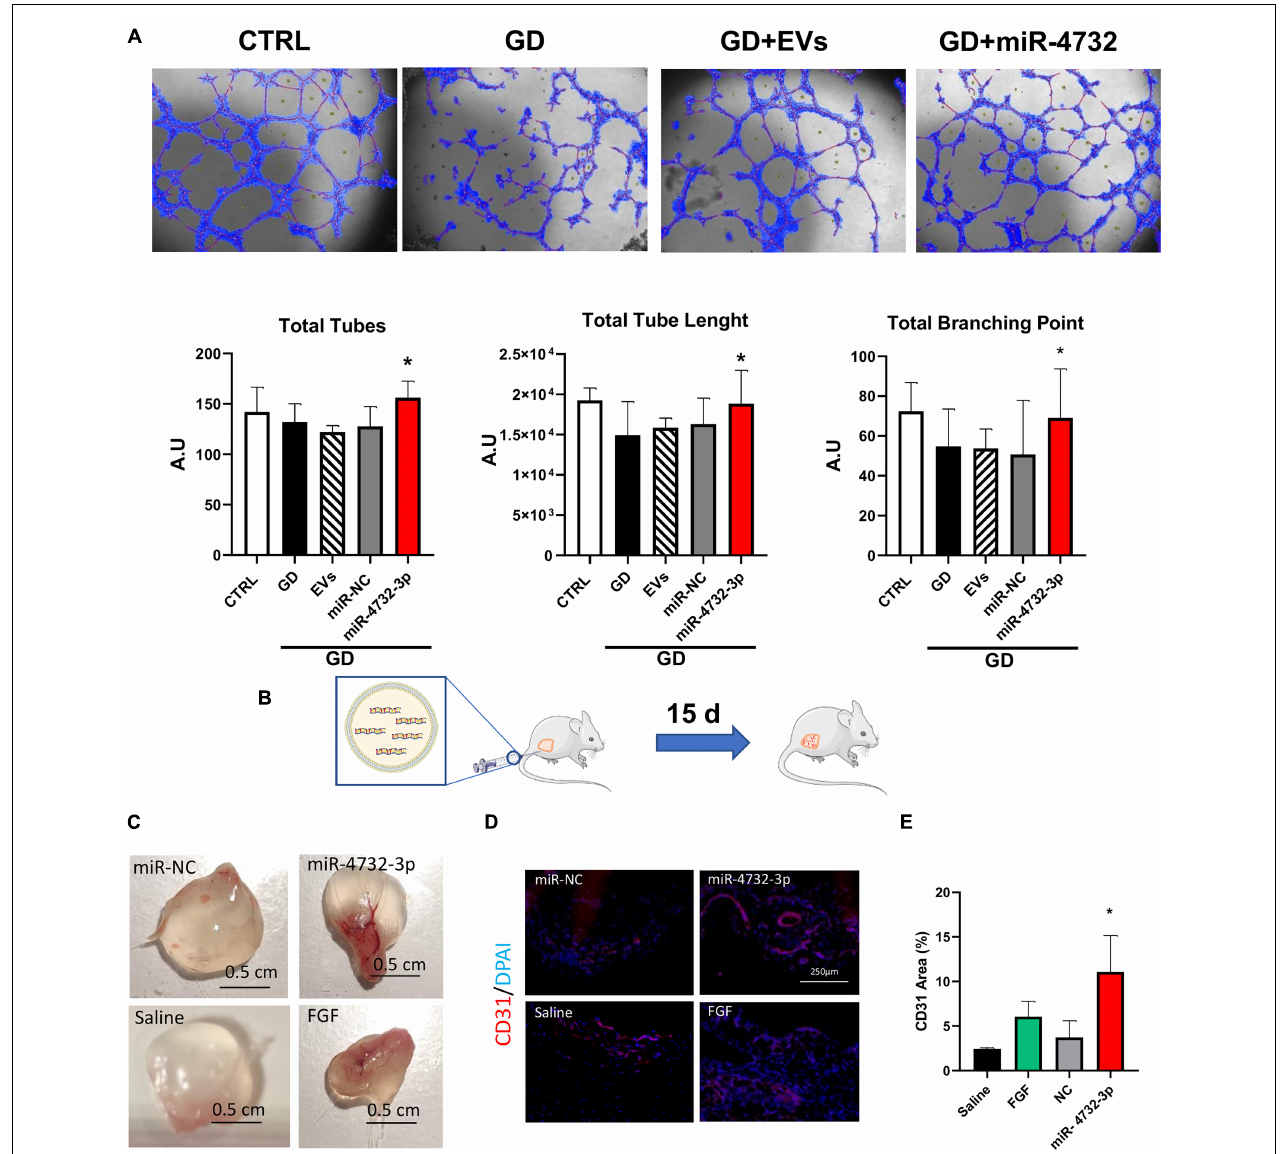
FIGURE 5 | Effect of EVs and miRNA 4732-3p on angiogenesis. (A) Representative images and quantification of the tubular structures in endothelial cells in standard culture condition (CTRL) in glucose deprivation (GD), with or without 30 µ g/mL of EVs(EVs), 20 nM lipofectamine-miRNA-4732-3p complexes (miR-4732-3p) or 20 nM of a negative control miRNA (miR-NC) and quantification of total tubes, total tube length and total branching points. (B) Scheme of Matrigel plug assay in nude mice to measure angiogenesis. Mice were divided into four groups. Matrigel was mixed with saline, 100 ng/mL FGF and 20 U heparin (FGF), 20 µ g of negative control miRNA (miR-NC) or 20 µ g of miR-4732-3p in Maxsuppressor reagent (miR-4732-3p). Mice were sacrificed 15 days after Matrigel injection. (C) Representatives images of extracted plugs (scale-bar = 0.5 cm). (D) Representative images of CD31-positive staining in the plugs by immunohistochemistry. (E) Quantification of CD31-positive area in the plugs ( n = 5, * p < 0.05).